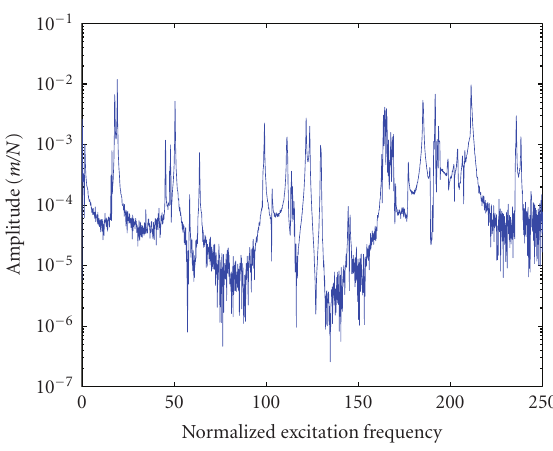
Figure 6: Wide frequency band measurement on a